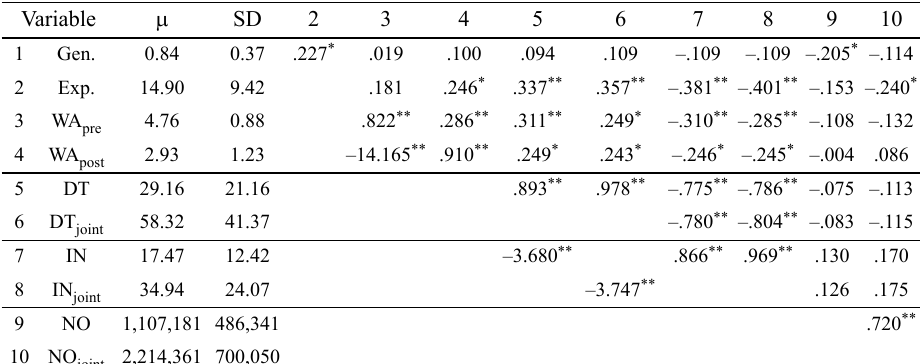
Table 3. Descriptive, reliability and correlation statistic of overall sample (n = 100)